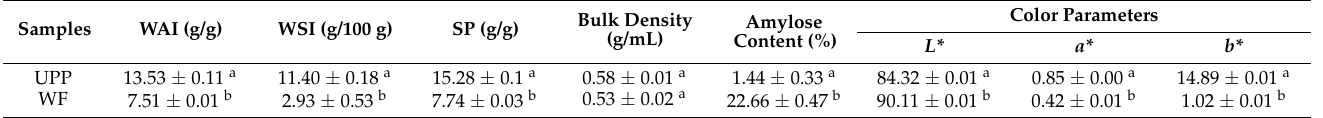
Color Parameters Amylose (g/mL) Content (%) b*